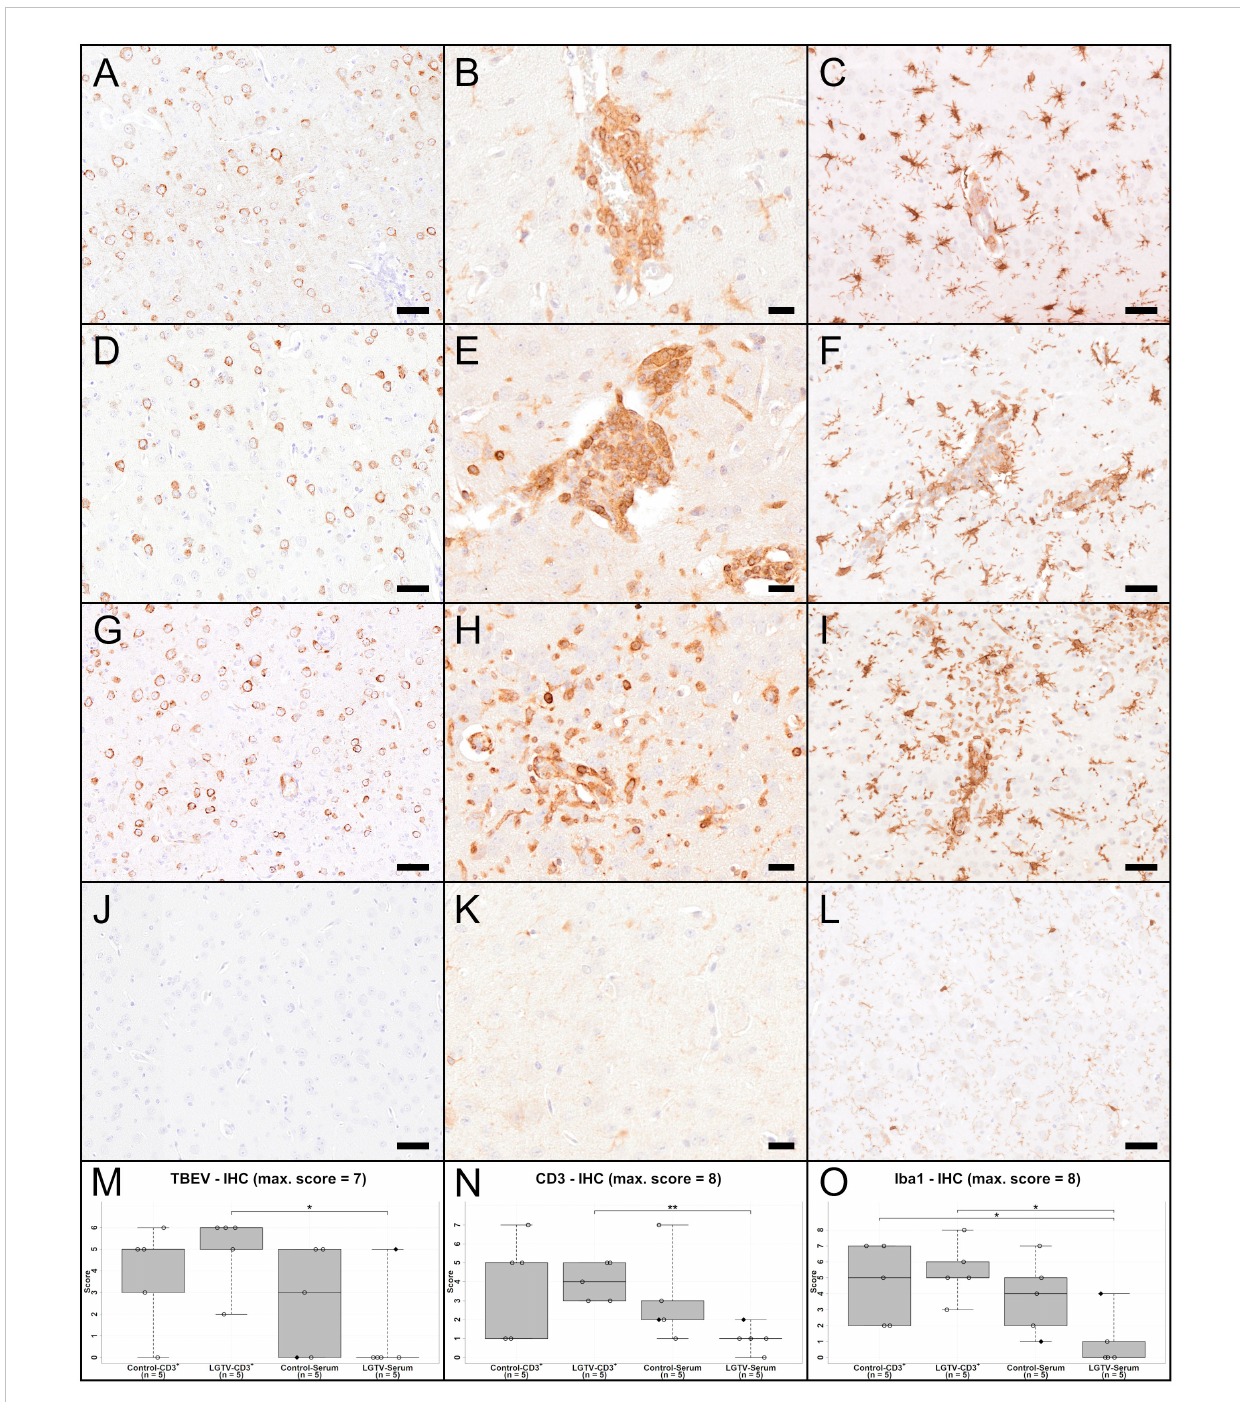
FIGURE 7 IHC of cerebral cortex for TBEV (A, D, G, J) , T cell marker CD3 (B, E, H, K) and microglia/macrophage marker Iba1 (C, F, I, L) of one representative mouse from each group (A – C) : CD3 + T cell transfer from control donors; (D – F) : CD3 + T cell transfer from LGTV infected donors; (G – I) : serum transfer from control donors; (J – L) : serum transfer from LGTV infected donors). TBEV E protein is detectable in the cytoplasm of neurons in all mice (A, D, G) except the mouse in the serum transfer group from LGTV infected donor mice (J) . CD3-positive T cells are detectable in the vascular wall as well as the perivascular space of affected mice (B, E, H) , while no immunoreaction is visible in the mouse of the serum transfer from LGTV infected donor mice (K) . There is distinct increase in staining intensity and number of Iba1-positive microglia/macrophages indicating activation and proliferation of microglia and/or proliferation/in fi ltration of macrophages in affected mice (C, F, I) in comparison to the mouse of the serum transfer group from LGTV infected donor mice in which microglia are normal-sized with fi ne processes (L) . Scale bar (A, D, G, J, C, F, I, L) : 50 µm; scale bar (B, E, H, K) : 20 µm. (M – O) display box plots of the scoring values of IHC for TBEV (TBEV-IHC; (M) , IHC for CD3 (Iba1-IHC; (N) and IHC for microglia/ macrophages marker Iba1 (Iba1-IHC; (O) of cerebral cortex for each experimental group. Signi fi cant differences detected by pairwise Wilcoxon rank- sum tests after non-parametric ANOVA and multiple testing adjustment are indicated by asterisks (* p < 0.05; ** p< 0.01). Mice that differed in their clinical state from other mice in the control and LGTV serum recipient group are highlighted as rhombus shaped symbols in the box